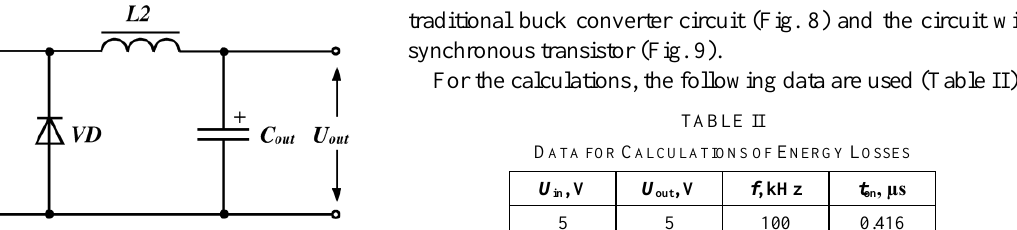
Fig. 8. The classical circuit of buck converter.